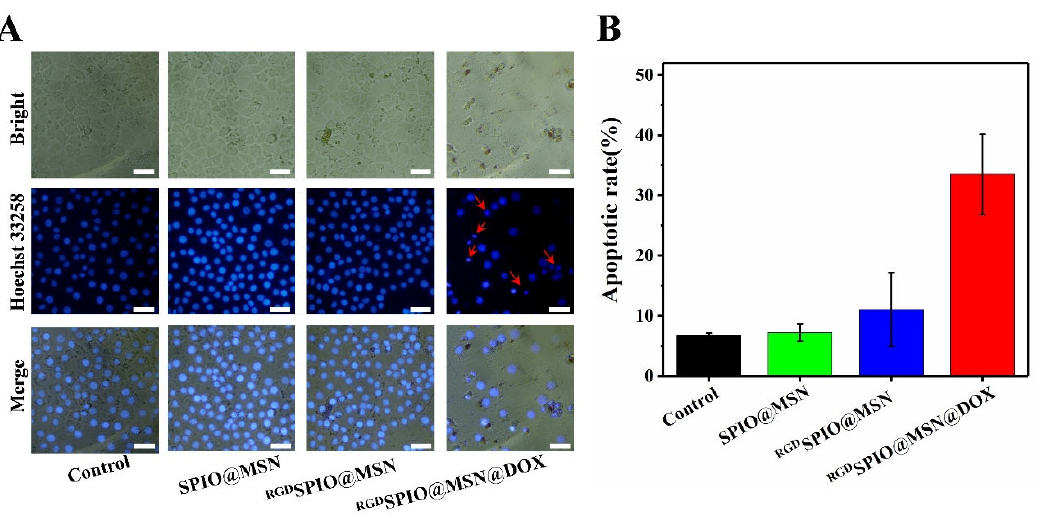
Figure 6. Hoechst 33258 staining of HepG2 cells treated with different formulations. ( A ) The fluorescence images of observed nuclei of HepG2 cells treated for 24 h with various nanocomposites,